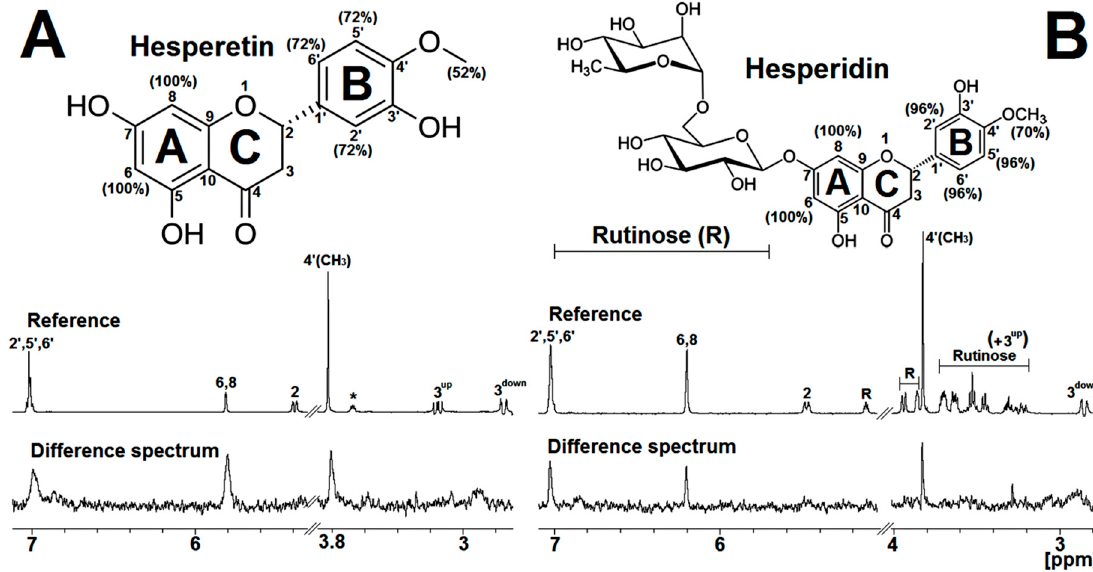
Figure 2. STD-NMR results obtained for the M 2-1 / flavanone binding collected at 600 MHz and 298 K (25 °C). ( A ) At the top, it is presented the molecular structure of the HST with percentage of the binding epitopes in parentheses. In the middle, 1D 1 H NMR reference spectrum assigned with respective hydrogen atoms named in the molecular structure. At the bottom, 1D 1 H NMR difference spectrum for the binding of hesperetin (HST) to M 2-1 protein. The asterisk denotes a sign of ethanol. ( B ) On the top, it is shown the molecular structure of the hesperidin (HSD) with percentage of the binding epitopes in parentheses. In the middle, 1D 1 H NMR reference spectrum assigned with respective hydrogen atoms named in the molecular structure. The signal from the rutinose group of HSD are depicted by R letter. At the bottom, 1D 1 H NMR difference spectrum for the binding of HSD to M 2-1 protein. The NMR spectra were acquired with 50 µM of protein and 250 µM of HST or HSD. For better visualization of the NMR data, the spectra were expanded to the spectral region with well-resolved difference signals. The signal region from water (HDO) molecule was removed.